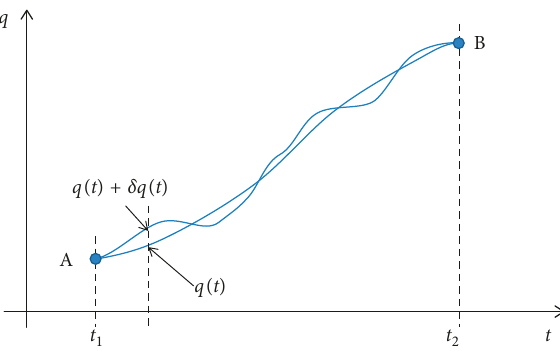
Figure 1: Virtual trajectory (thin line) differs from real trajectory (thick line) by the virtual deviation δ q ( t ) , which is zero in the start and end states A and